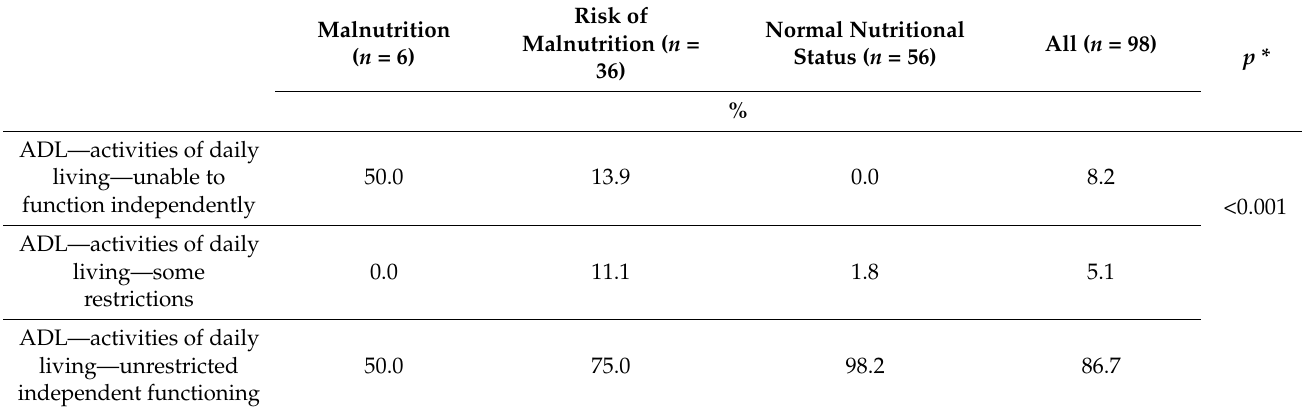
Table 2. Independence in daily activities by nutritional status.